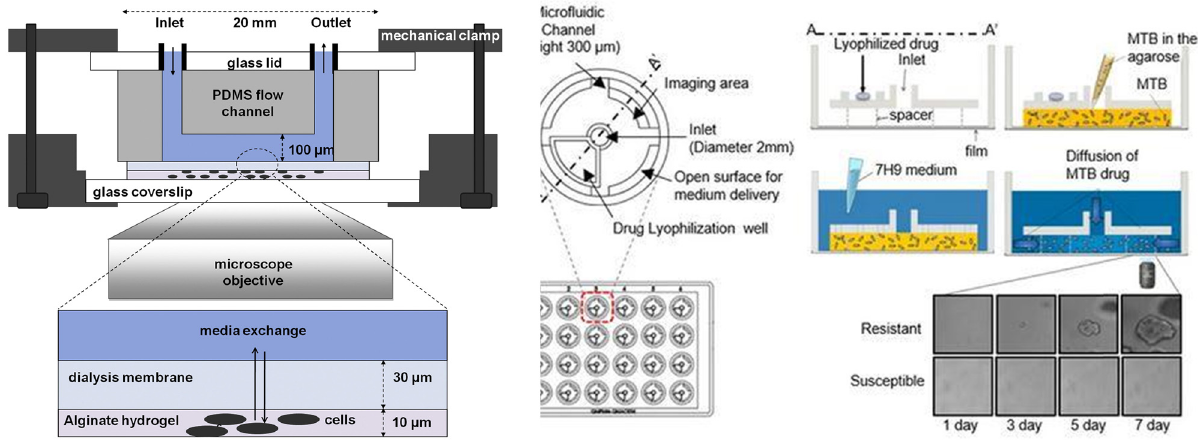
Figure 1: Left: Schematic of the micro fl uidic device presented in ref. [ 21 ] , based on the hydrogel matrix. On top of a coverslip, cells are embedded in the thin alginate hydrogel, covered by a cellulose dialysis membrane that allows media di ff usion. Mechanical clamps and a glass lid sealthe PDMS fl owchannel structure. Right: Sketch ofthe automatic disc agarose channel chip and trapping methodology inagarose matrix used in refs [ 18,22 ] . ( leftmost ) Top view of the chips within 24 - well plate, with channels, inlet, and drug reservoirs depicted. ( rightmost ) The experimental process ofloading Mtb cells within an agarose matrix, covering with media and di ff usion of anti - TBdrugs within the media can be observed. Images reproduced with permission from TB ( left, [ 21 ]) and Applied Microbiology and Biotechnology ( right, [ 22 ])